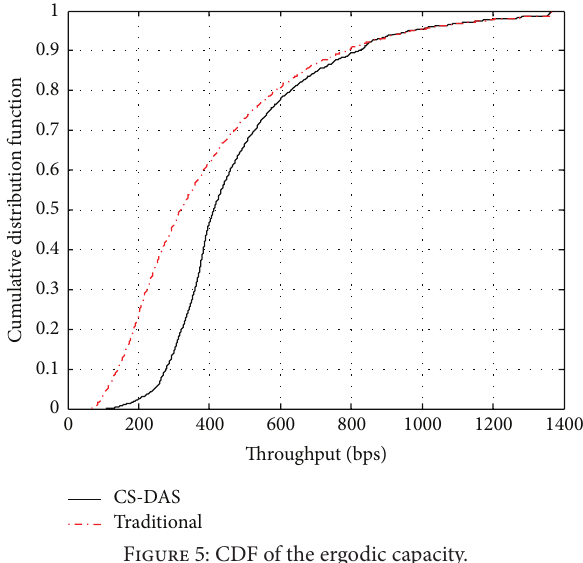
Figure 5: CDF of the ergodic